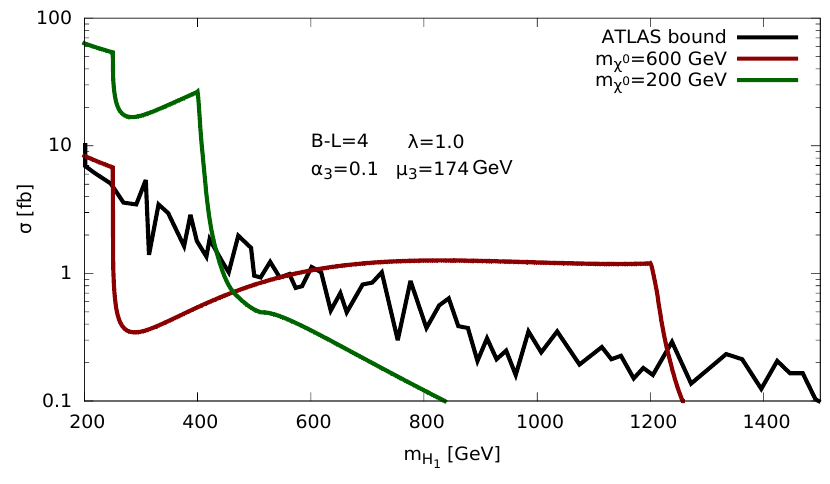
Figure 8 . The diphoton production cross-section is shown as a function of the singlet scalar mass for two di(cid:11)erent choices of the DM mass. We draw these curves for B (cid:0) L =4 case with (cid:11) 3 (cid:22) 3 = 0 : 1 v EW and (cid:21) = 1 : 0. For comparison, the solid black line shows the ATLAS bound [39].